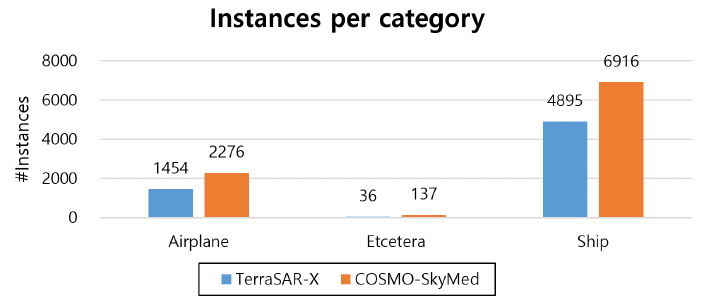
Figure 4. Number of annotated instances per category for TerraSAR-X and COSMO-SkyMed